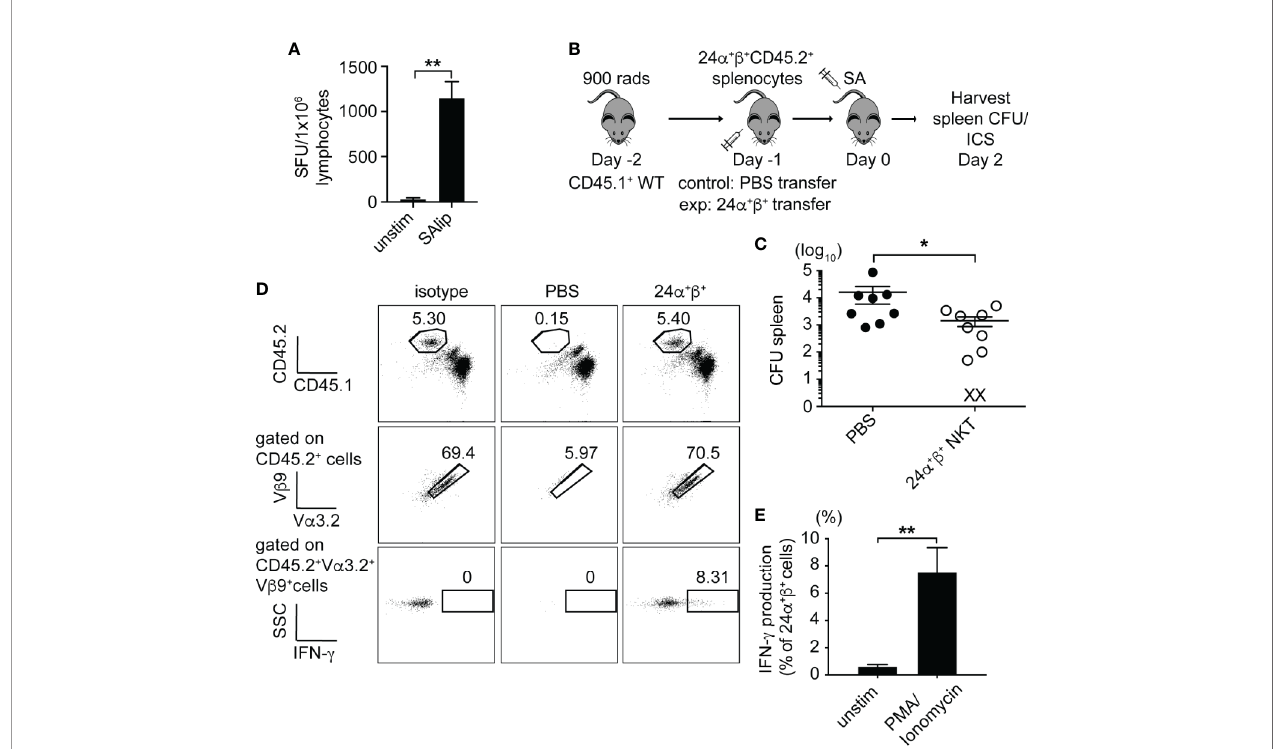
FIGURE 7 | Type II NKT cells protect mice from systemic SA infection. (A) IFN- g ELISPOT of naïve 24 a + b + lymphocytes from liver co-cultured with B6 DCs unpulsed or pulsed with total SA lipids (SAlip) (10 µg/ml). (B) Schematic of type II NKT cell adoptive transfer experiment. (C) Bacterial CFU in the spleen of recipient mice at 2 dpi, PBS= control group (D, E) . Representative FACS plots of adoptively transferred 24 a + b + NKT cells from spleen of 2 dpi recipient, % IFN- g production after stimulation with PMA/Ionomycin or unstimulated (2 h + 4 h BFA), quanti fi ed in E (N=8 – 10 mice/group). Statistical analysis: (A) one-way ANOVA, (C) Mann- Whitney test, (E) 2-way ANOVA. *p < 0.05; **p <